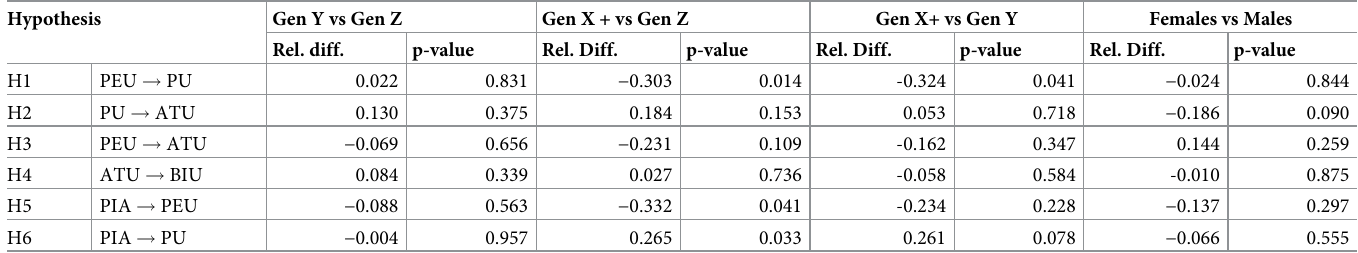
Table 3. Outcomes of the tests between generational cohorts and gender